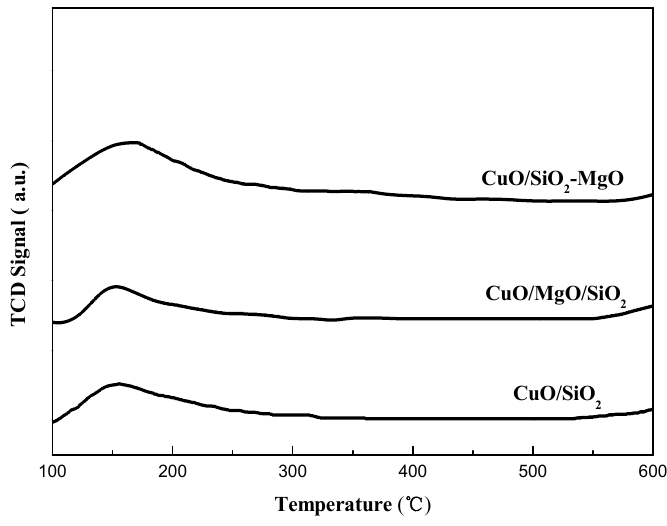
Figure 9. NH 3 -TPD of catalysts.